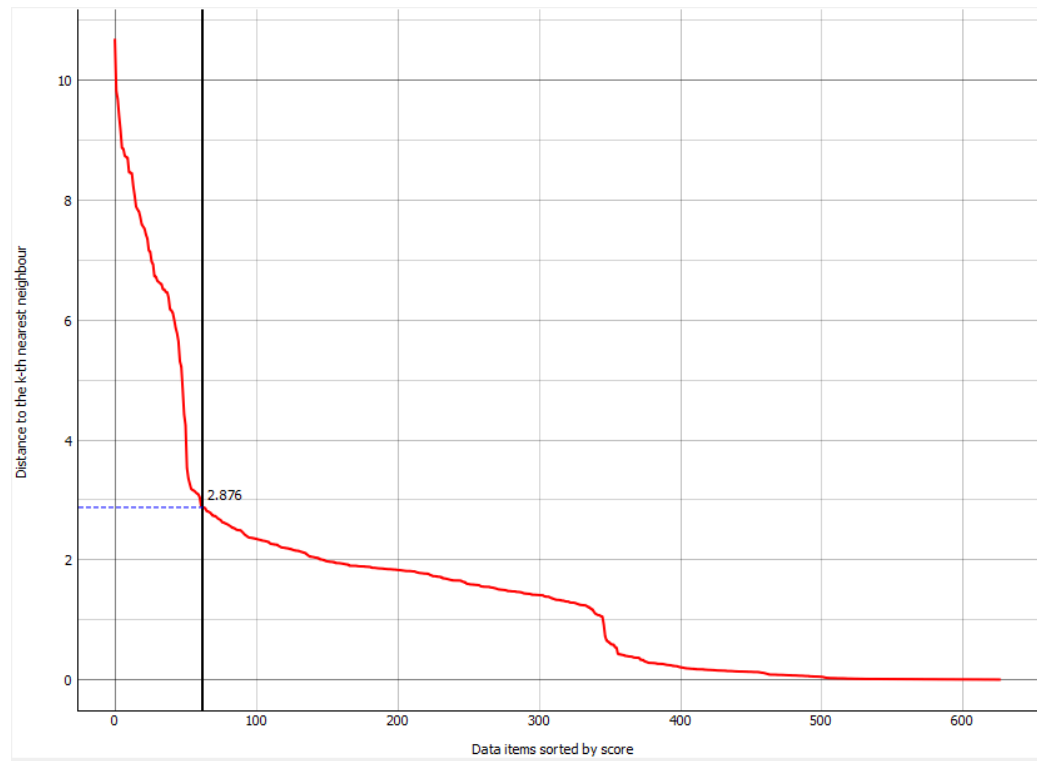
Figure 4. DBSCAN clustering algorithm for Bitcoin k-NN distance setting. Note: The density-based spatial clustering algorithm gives the idea of an ideal selection for the neighborhood distance setting. Here, 2.876 has been rounded up to 3 in the empirical